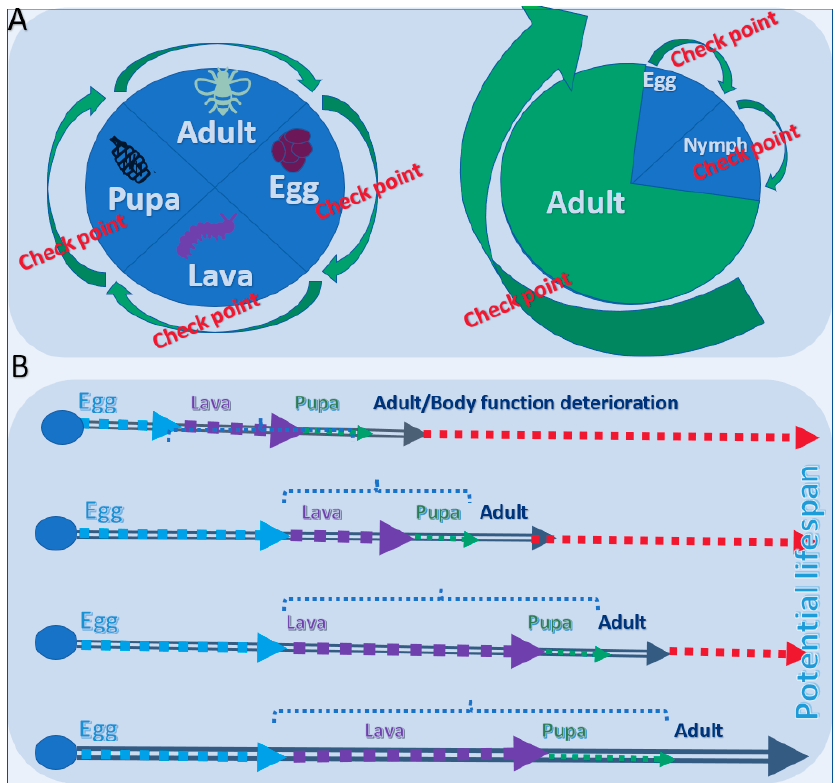
Figure 3. Life stages and lifespan of insects. ( A ) Four stages of the life cycle of most insects (left) and three stages of the life cycle represented by a grasshopper (right). Stopping any of these growth stages will kill the insect. ( B ) Extension of dormancy of egg, slow-down the growth of lava (or nymph), and maturation of pupa will elongate the lifespan.